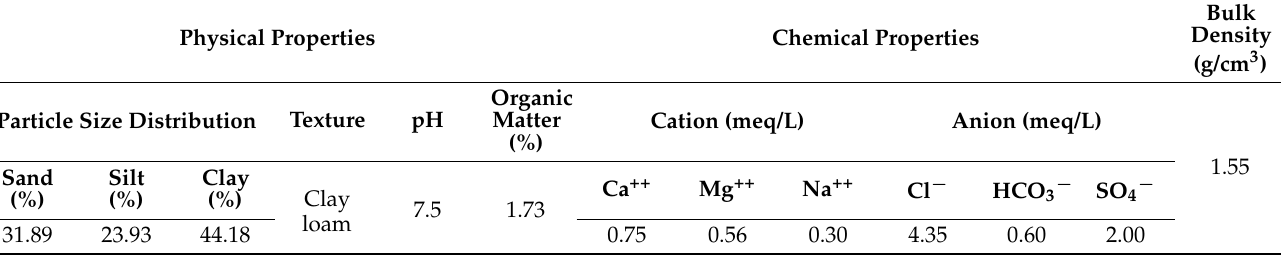
Table 1. Average values from physical and chemical analyses of experimental soil prior to conducting the experiment.